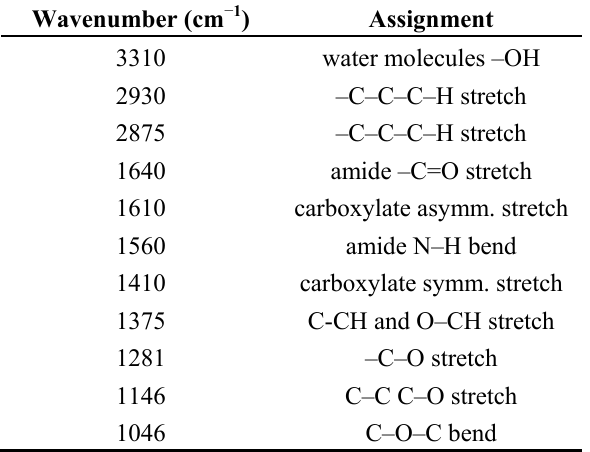
Table 5. Peak wavenumbers (cm − 1 ) and assignments for Hyal